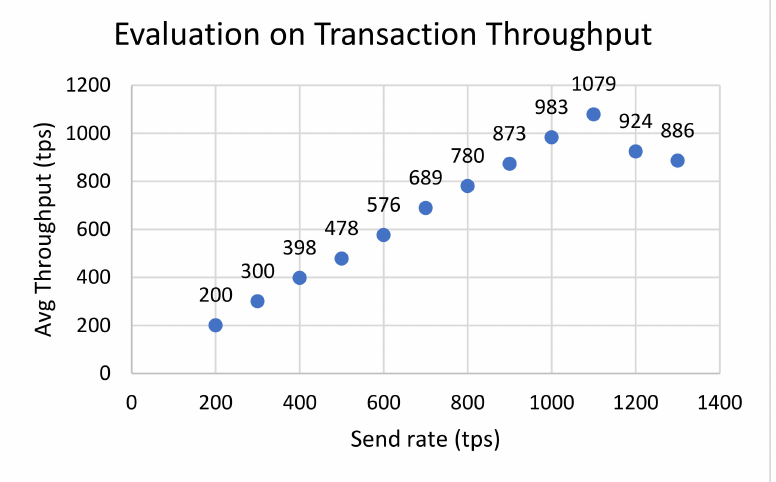
Figure 6. Effect of the send rate on blockchain network transaction throughput using Hyperledger Fabric. Reprinted/adapted with permission from Ref. [42]. 2020, Elsevier